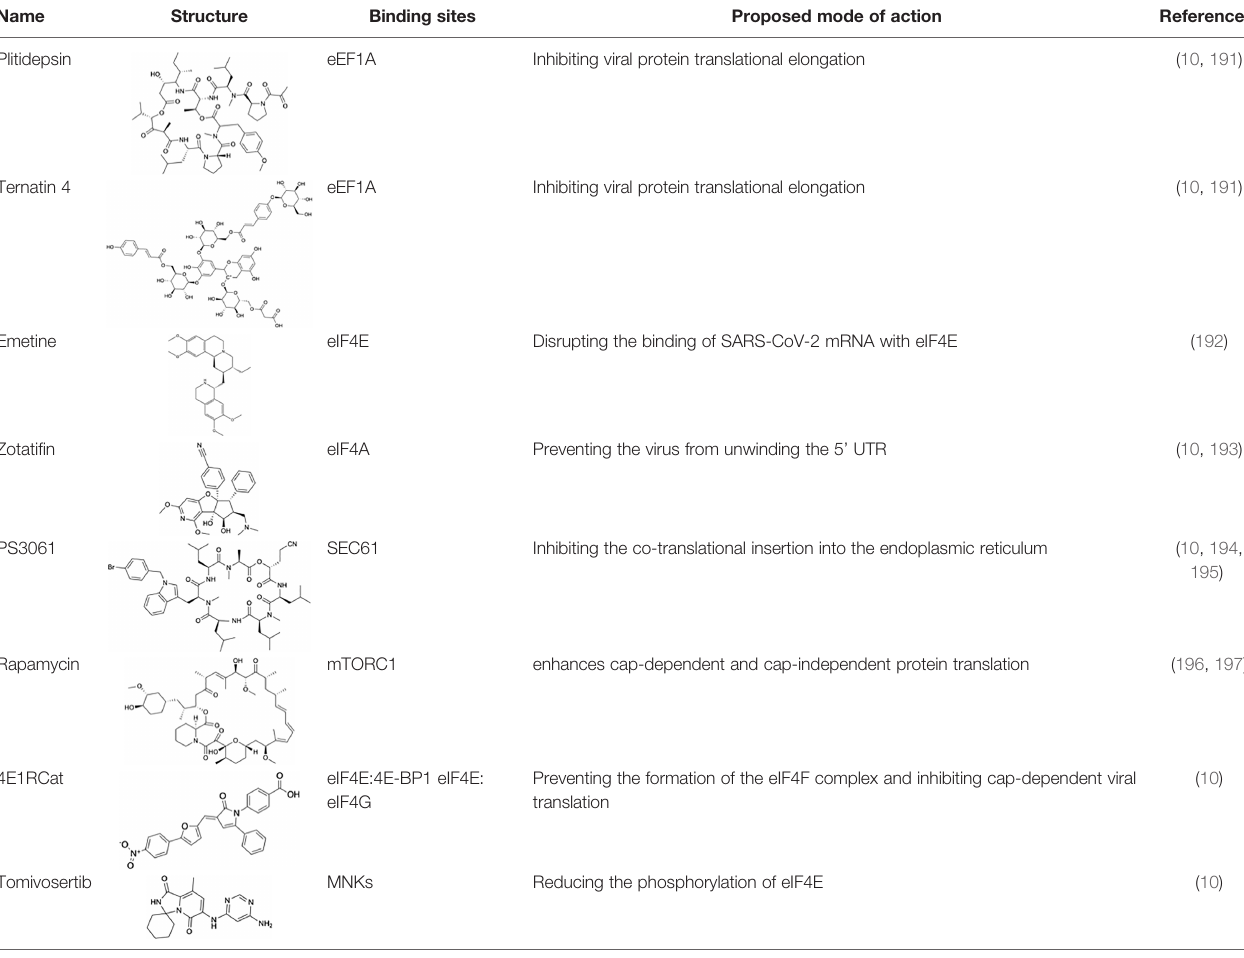
TABLE 1 | Protein translational inhibitors used for